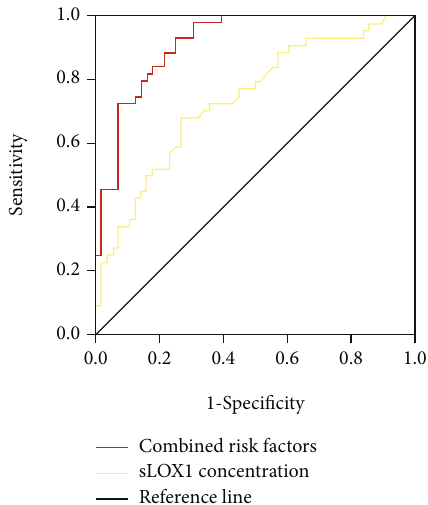
Figure 6: ROC curve analysis on predictive values of age, baseline NIHSS score, sLOX-1 concentration, time from onset, neutrophil count, and combined risk factors. The optimal cuto ff value was 575.39pg/mL, with a sensitivity of 93.2% and a speci fi city of 75% (AUC: 0.916, 95% con fi dence interval: 0.863 – 0.968, p < 0 : 0001